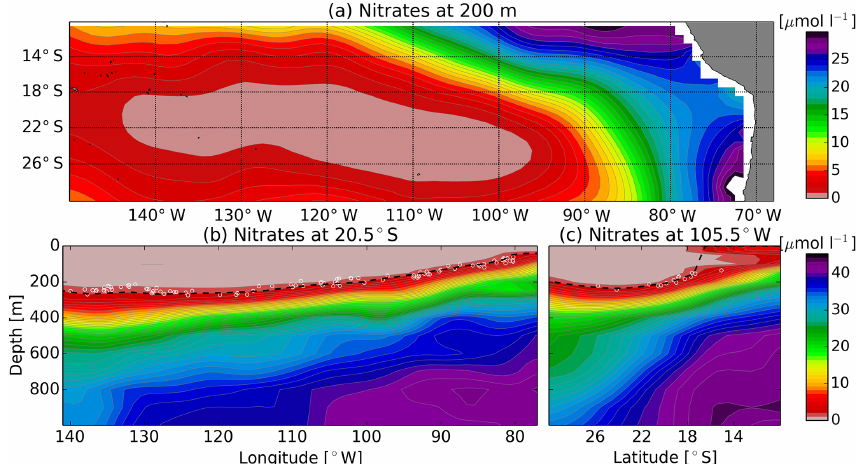
Figure 2. Climatological January nitrate from WOAPISCES in the southeast Pacific. (a) Horizontal section at 200m depth, (b) vertical section at 20.5 ◦ S and (c) vertical section at 105.5 ◦ W. Dashed black lines in (b) and (c) indicate the 2molL − 1 isoline. White dots are a random sample of the simulated water parcels at their initial